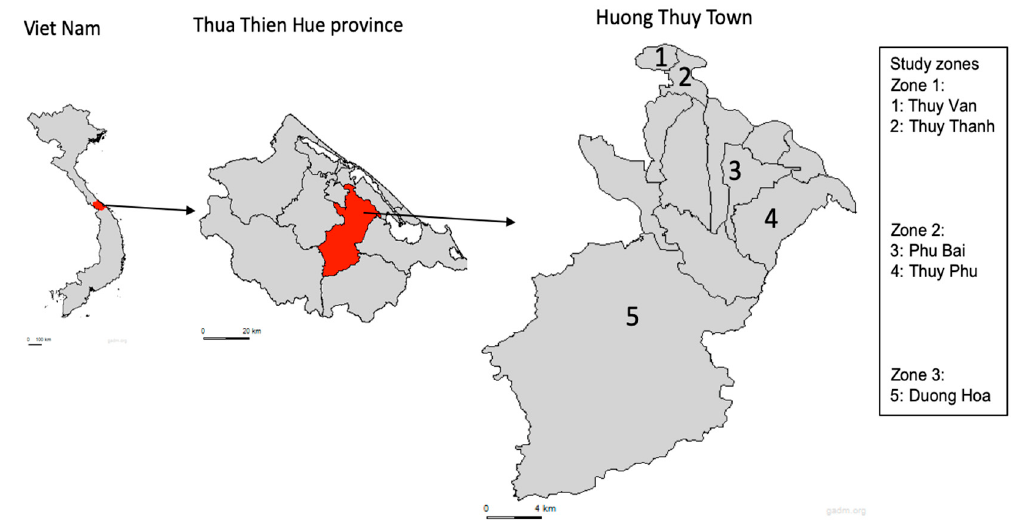
Figure 2. Mapping of study sites (Source: Global Administrative Areas (GADM), 2018).